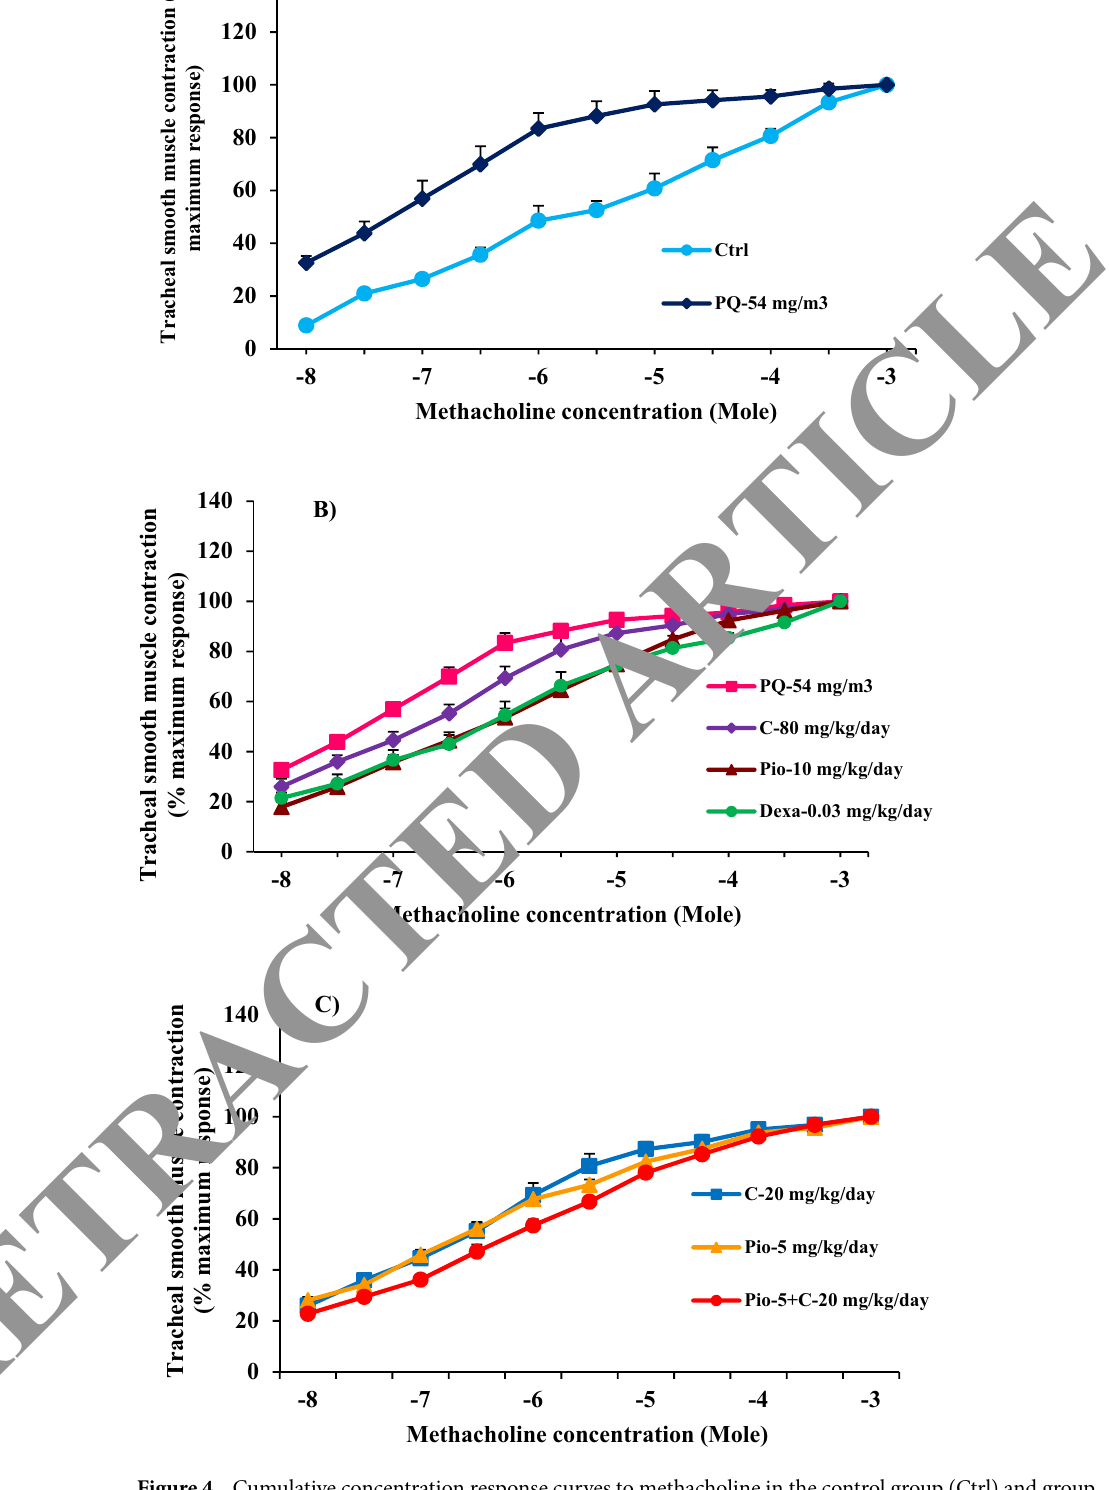
Figure 4. Cumulative concentration response curves to methacholine in the control group (Ctrl) and group exposed to paraquat aerosol at doses of 54 mg/m 3 (PQ-54 mg/m 3 ), ( A ) PQ-54 mg/m 3 , groups exposed to PQ-54 mg/m 3 and treated with 10 mg/kg/day pioglitazone (Pio-10 mg/kg/day), 80 mg/kg/day carvacrol (C-80 mg/kg/day) and 0.03 mg/kg/day dexamethasone (Dexa-0.03 mg/kg/day), ( B ) and groups exposed to PQ-54 mg/m 3 and treated with 5 mg/kg/day pioglitazone (Pio-5 mg/kg/day), 20 mg/kg/day carvacrol (C-20 mg/ kg/day) and 5 mg/kg/day pioglitazone + 20 mg/kg/day carvacrol (Pio-5 mg/kg + C-20 mg/kg), ( C